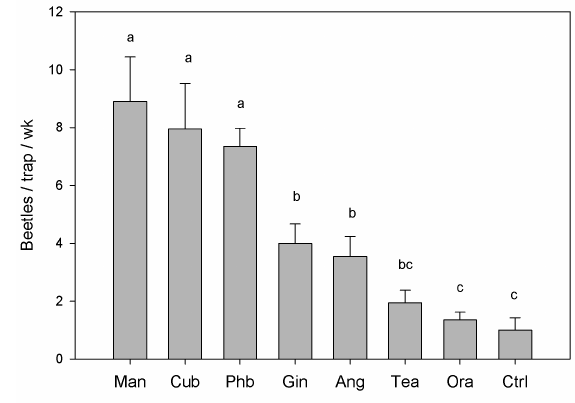
Figure 2: Mean (± SE) captures of female Xyleborus glabratus with seven essential oils deployed in a 4-wk field test conducted in Highlands County, FL, USA. Treatments consisted of manuka (Man), cubeb (Cub), phoebe (Phb), ginger root (Gin), angelica seed (Ang), tea tree (Tea), Valencia orange (Ora) oils, and an unbaited control trap (Ctrl); N = 5 traps per treatment. A membrane-based dispenser was used to prepare the lures, and each lure was loaded with 5 ml of neat oil. Bars topped with the same letter are not significantly different; adapted from